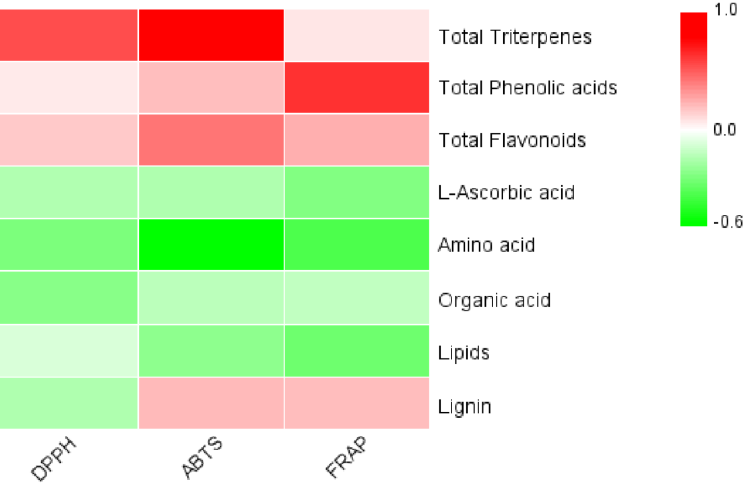
Figure 5. The correlation coefficient between active substances and antioxidant capacity.